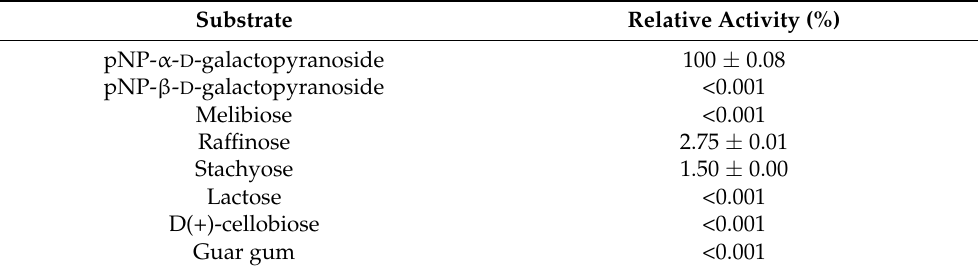
Table 2. Substrate specificity of the recombinant α -galactosidase.